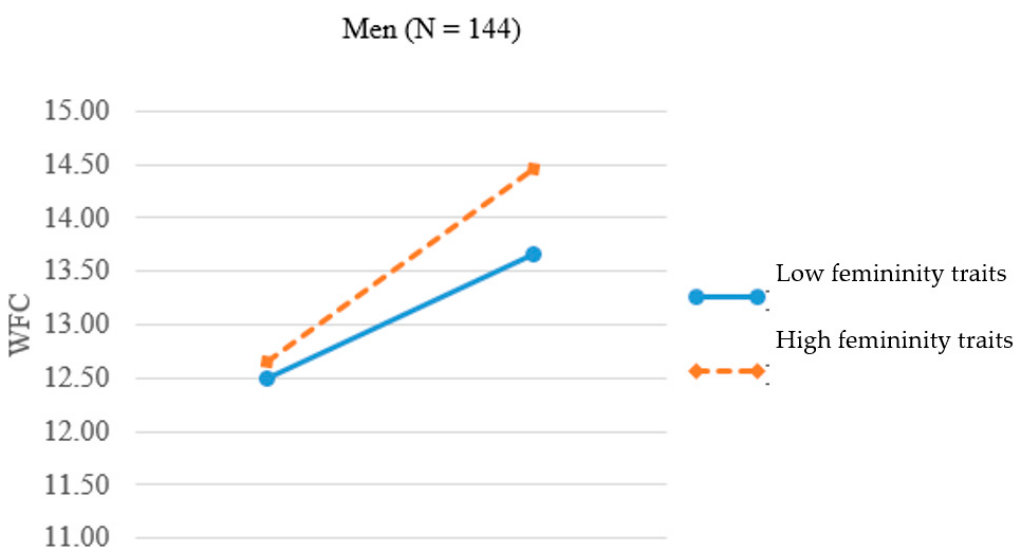
Figure 3. Interaction of femininity traits and family responsibility on WFC for men.